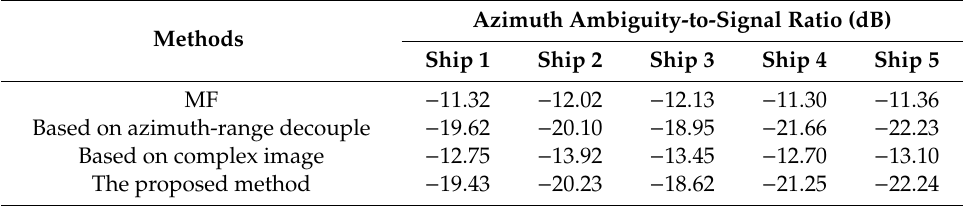
Table 5. AASR of target regions based on di ff erent methods with downsampled data (80%